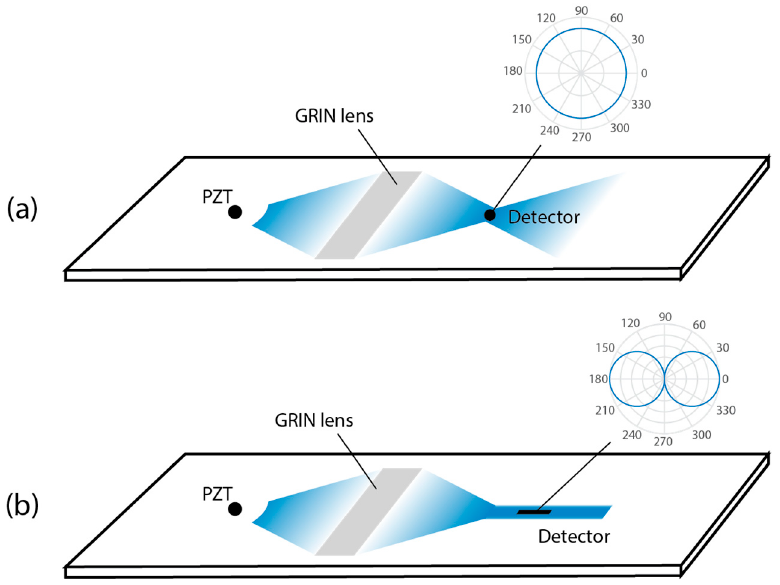
Figure 1. ( a ) Omni-directional ultrasound detector in GRIN lens focal spot. Inset shows the sensitivity of the detector. ( b ) Directional ultrasound detector in guided wave region after GRIN lens focal spot.